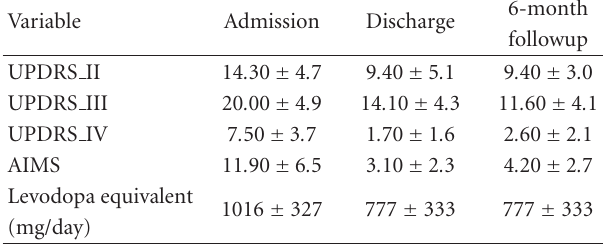
Table 1: Outcome variables at admission, at discharge after a 4- week intensive rehabilitation treatment, and at 6-month